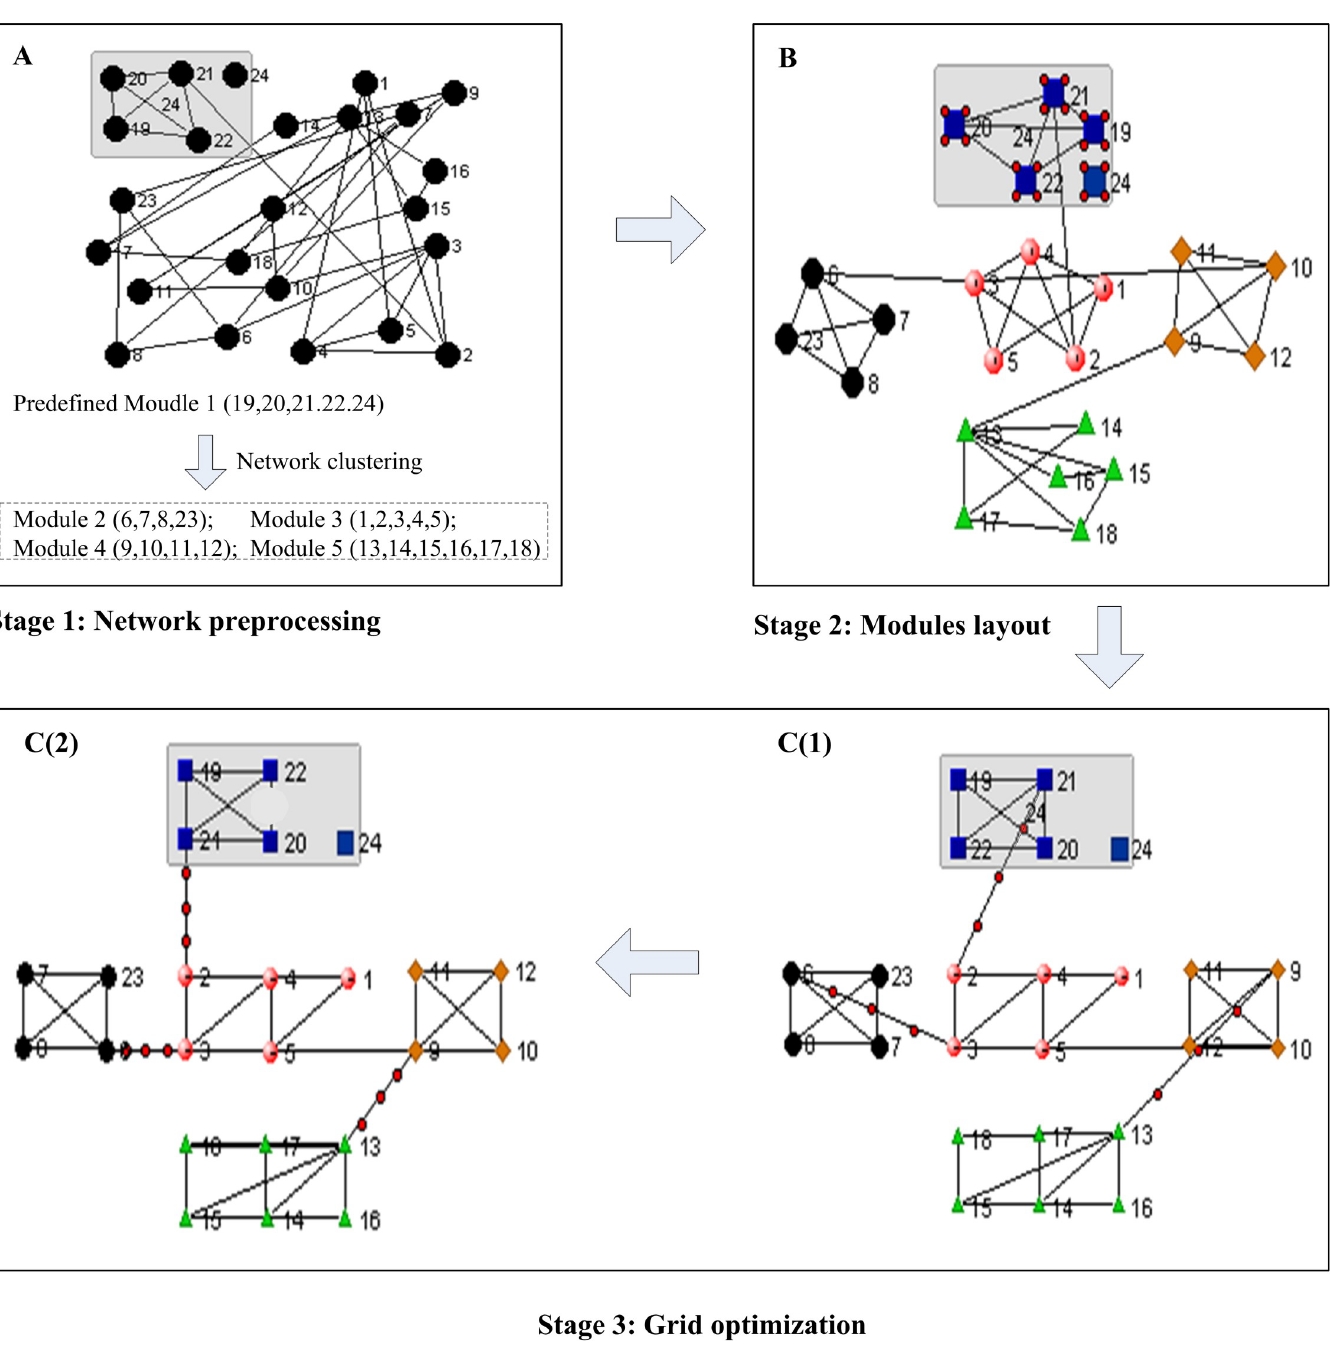
Fig 1. The flow chart of the GML algorithm. A network of 24 nodes is used for illustration of GML procedures. A) Nodes within the predefined modules (node 19, 20, 21, 22 and 24) are filtered out and the remainder is partitioned into modules using a clustering algorithm. Node 24 in the predefined module has no connection to the rest of nodes. B) All modules are placed on the plane according to the method of module layout, where each module is expanded to the square area to ensure a large enough space for placements of the nodes embedded in the module. C) The positions of all nodes are optimized in accordance with their inter/intramodule connectivity simultaneously to minimize edge-edge crossings through the method of grid